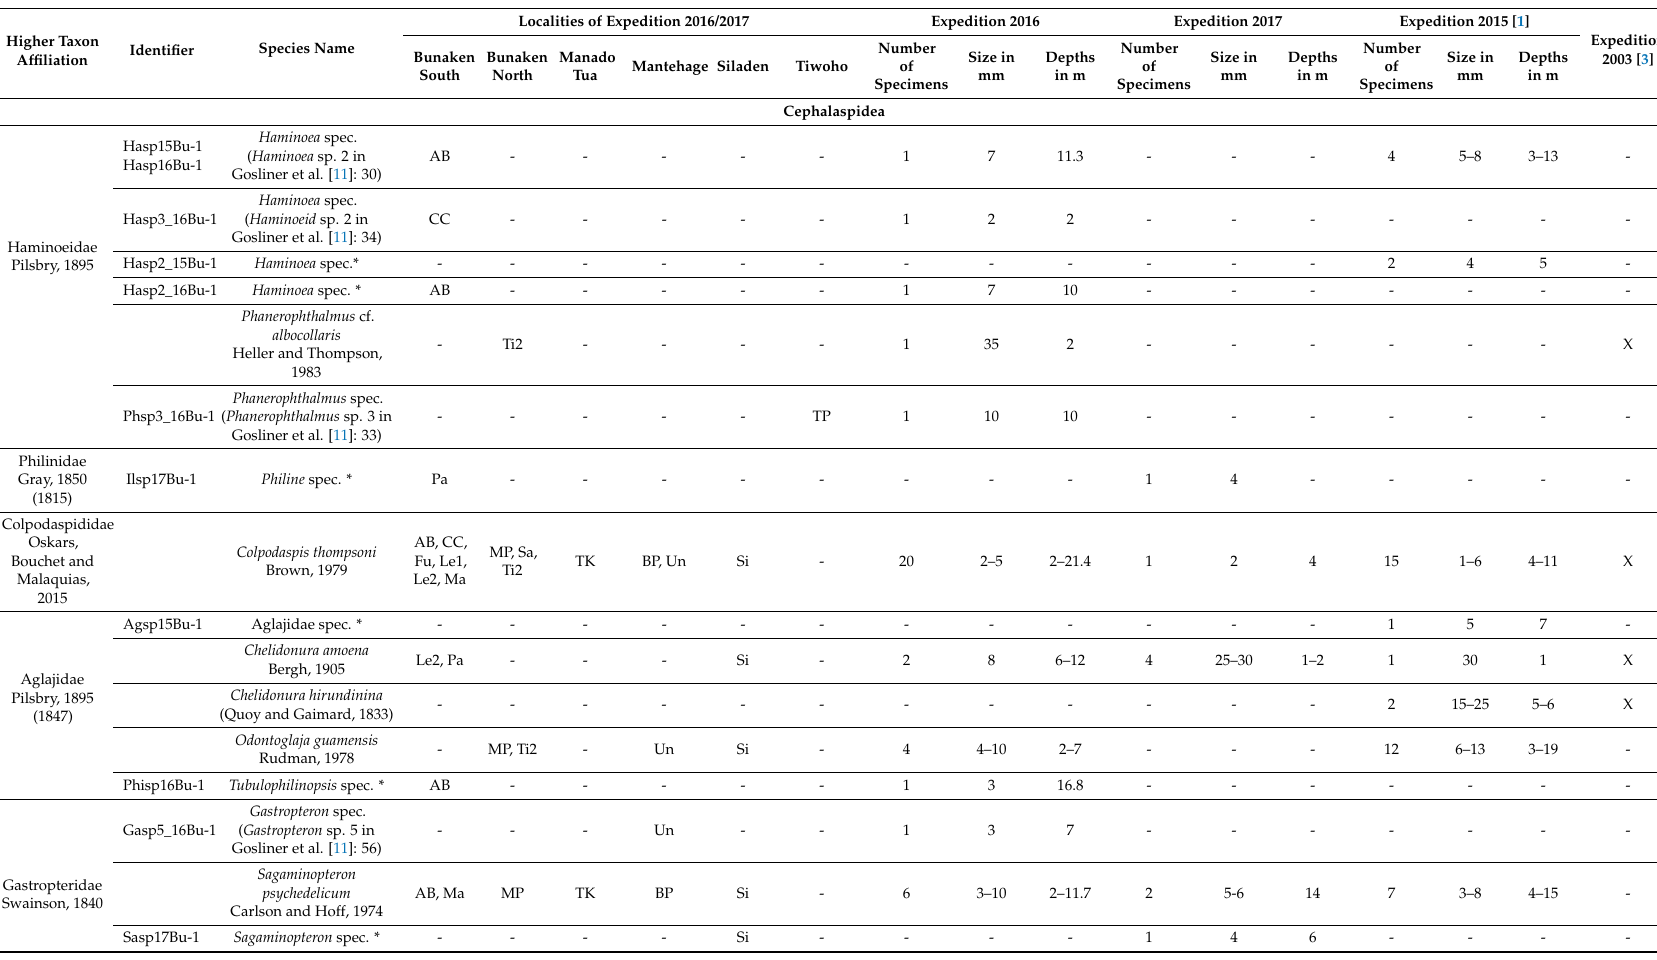
Table 2. List of species and specimen identifiers for the three recent collection events, and including Kaligis et al. [1]. Species that were recorded in Burghardt et al. [3] and recollected during the recent events are also indicated in the last column. Details of localities with abbreviations are specified in Table 1 or Kaligis et al. [1]. * indicates species that are not documented in literature or identification books, thus representing at-the-moment-unique species of